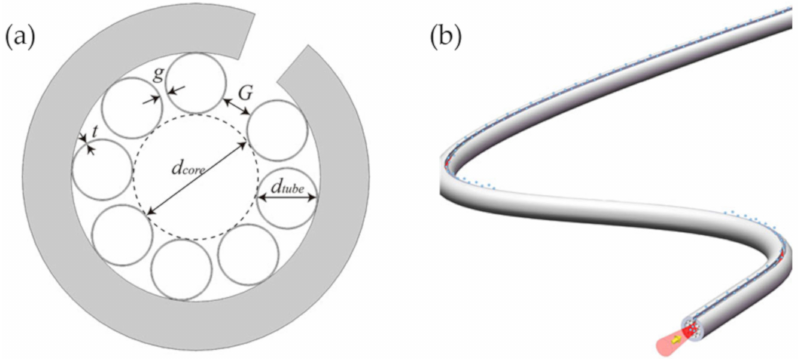
Figure 13. ( a ) Cross-section of the exposed-core unsymmetrical-gap nodeless HC-ARF. ( b ) Schematic three-dimensional image of the PCF with an exposed core, where the light interacts with matter